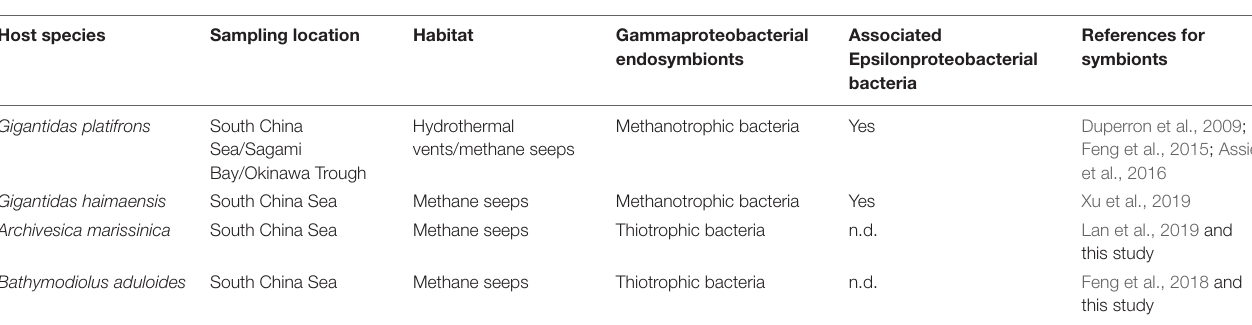
TABLE 1 | Information on the four studied seep